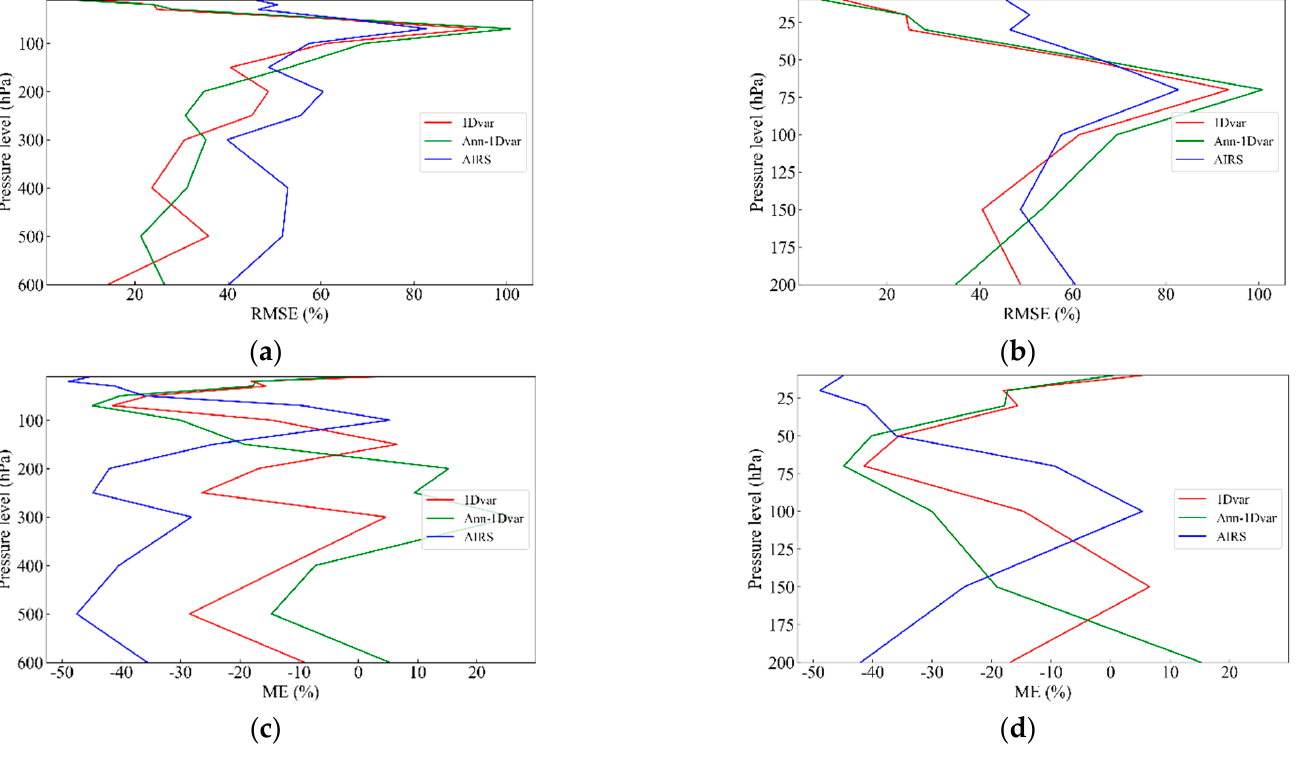
Figure 11. A comparison between the retrieved profile and AIRS product profile, where the true values are taken from WOUDC ozone site data: ( a ) 10–600 hPa RMSE (%), ( b ) 10–200 hPa RMSE (%), ( c ) 10–600 hPa ME (%), ( d ) 10–200 hPa ME (%). The red line, 1Dvar, is the traditional 1D − VAR physical retrieval algorithm retrieval ozone profile result obtained with GFS data as the initial profile. The green line, Ann_1Dvar, is the retrieval result obtained by adding the neural network method to optimize the initial profile combined with the traditional 1D − VAR physical retrieval algorithm. The blue line, AIRS, is the ozone profile of AIRS L2 Ozone product.